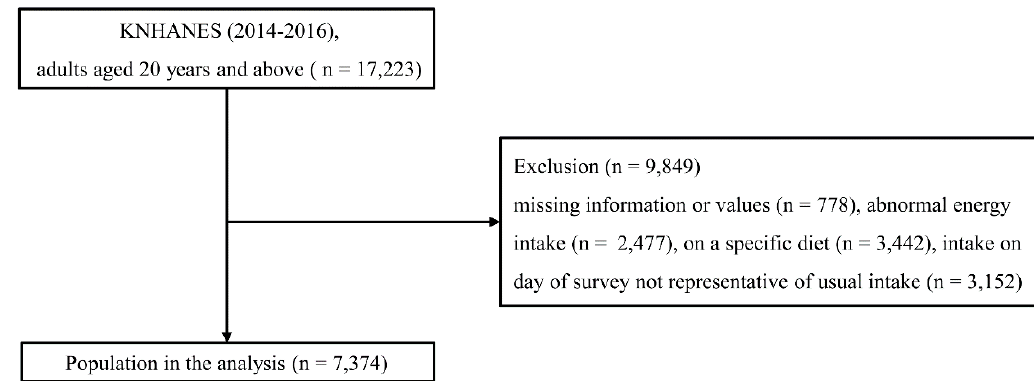
Figure 1. Study population: Data from the 2014–2016 Korean National Health and Nutrition Examination Survey (KNHANES).